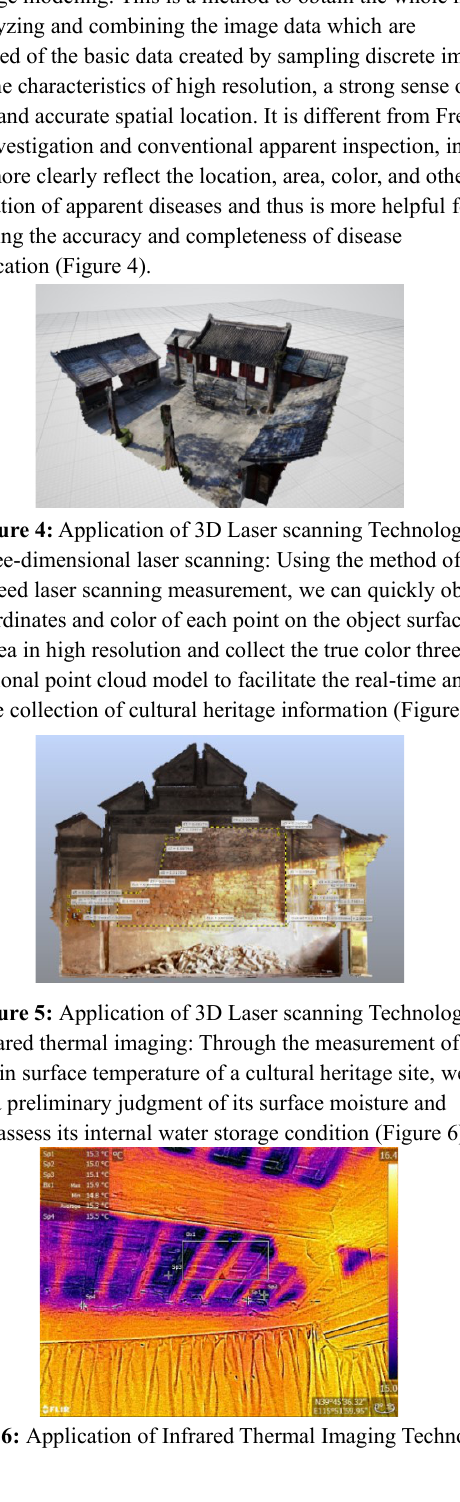
Figure 3: Display and application of panoramic photography